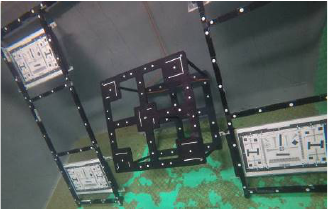
Figure 3. Underwater calibration field at Curtin University.